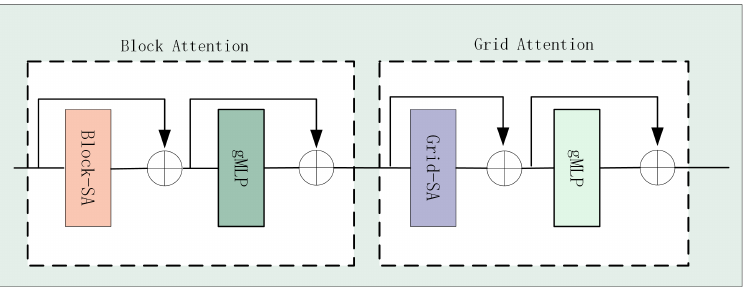
Figure 8. The MDA